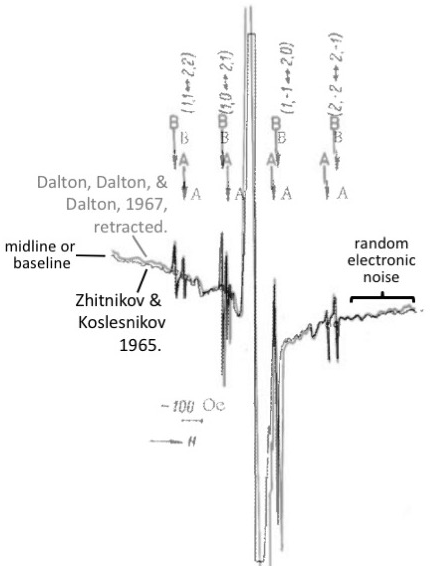
Figure 1: Overlay of spectrum in Zhitnikov and Kolesnikov 5 with that of Dalton et al., 4 later retracted. 6 Reproduced with permission of Elsevier, and of Soviet Physics – Solid State, under annual license with the Copyright Clearance Center.